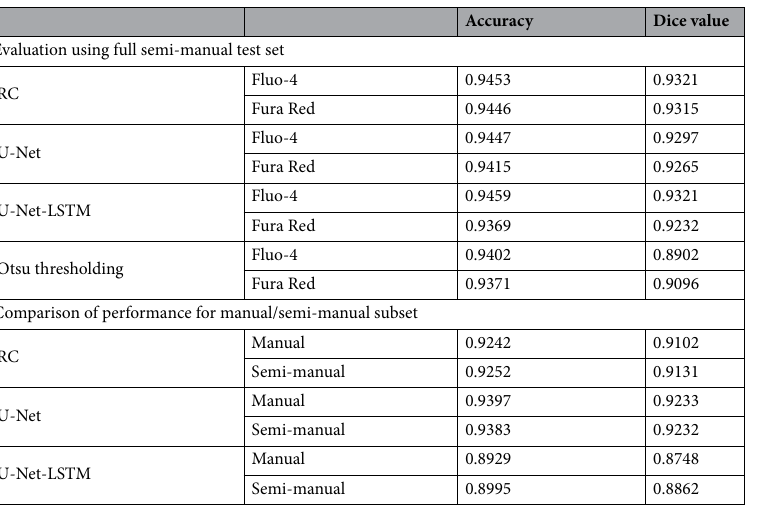
Table 2. Quantitative evaluation of the segmentation accuracy of the considered machine learning models for task 1 : reservoir computing, a standard U-Net, and an U-Net-based LSTM (evaluation metrics: mean class-wise accuracy and Dice coefficient). As a classical baseline approach, segmentation results for standard Otsu thresholding are also listed for the semi-manually generated test set. This test set consisted of 1500 frames captured from 30 Jurkat T-cells, i.e., 50 frames/cell. The subset used for the investigation of a potential bias due to the proposed semi-manual GT generation approach comprised a subset of 280 frames that were also manually labeled ( Ca 2 + indicator: